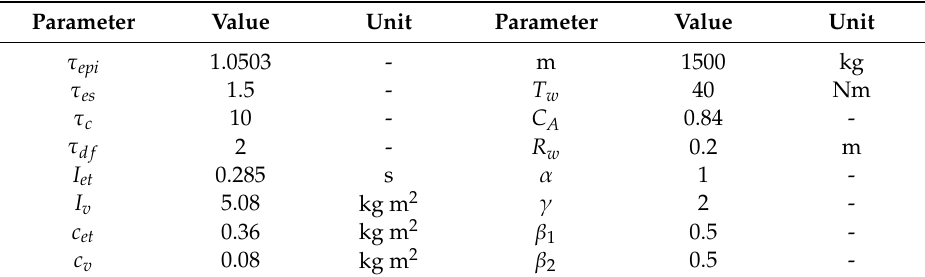
Table 1. Basic parameters and design requirements of AMT with a gearshift assistant